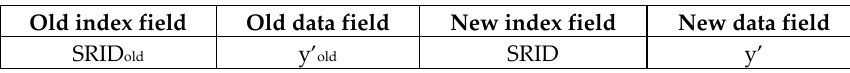
Figure 3. Readers’ index data table in Fan et al.’s scheme.